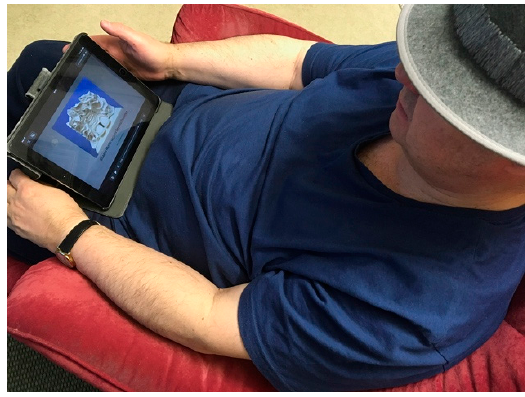
Figure 1. A deafblind CI user deflecting unwanted sounds by the use of a hat. Photographer: Riitta